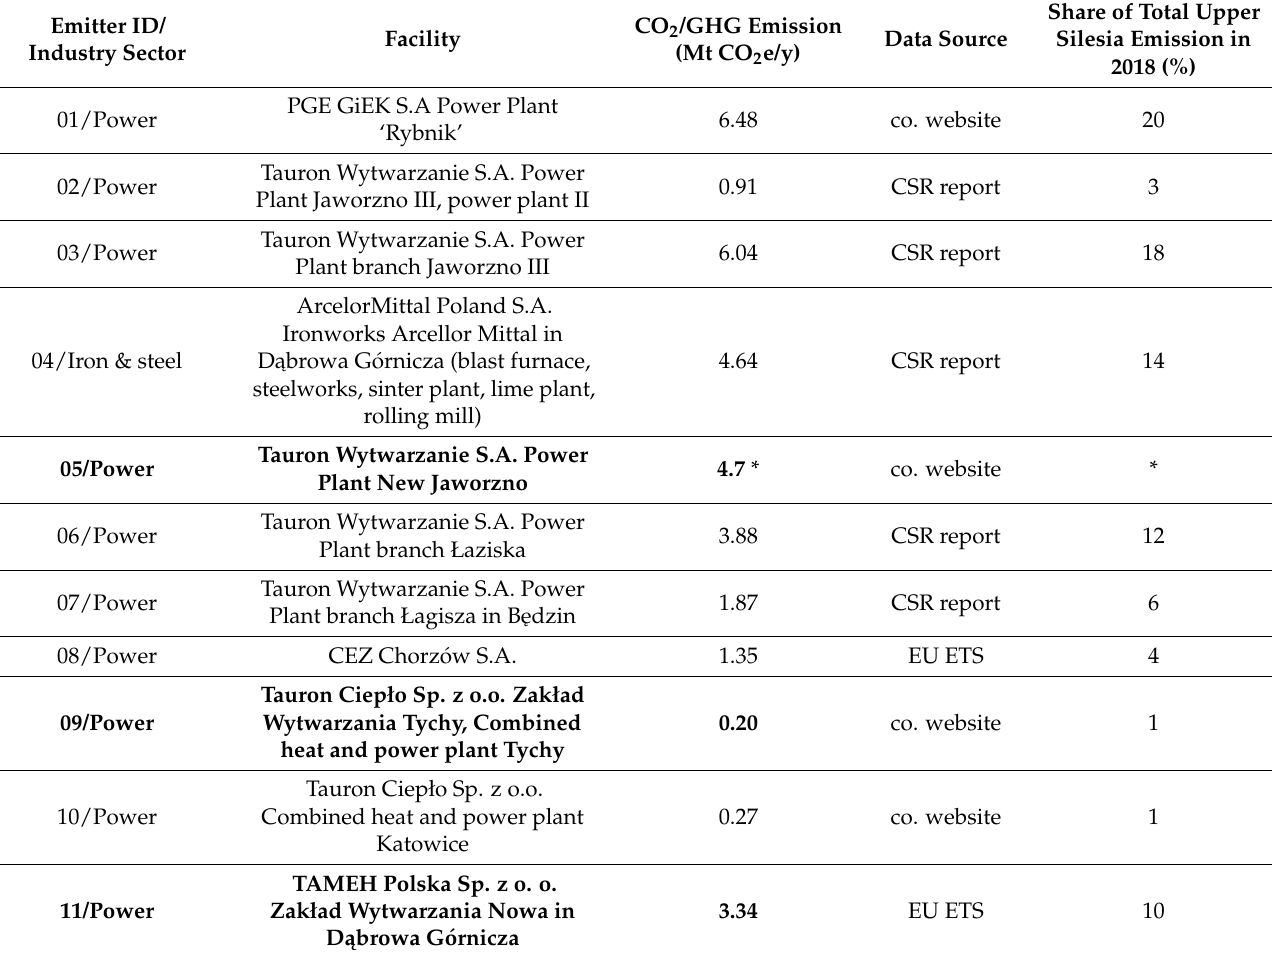
Table 1. Largest CO 2 emitters located in Upper Silesia with their annual